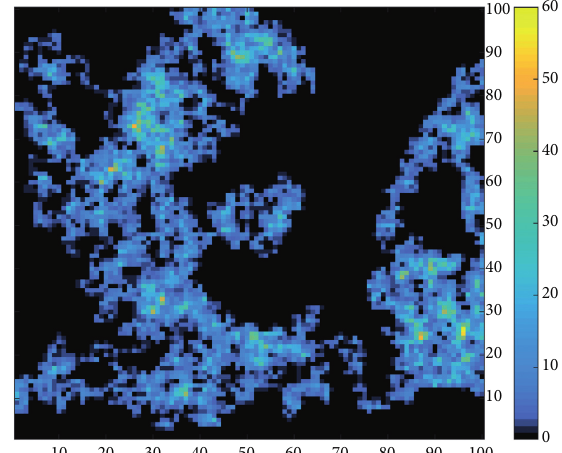
Figure 17: Color-coded grid coverage for 35,000 moves for motion in 4